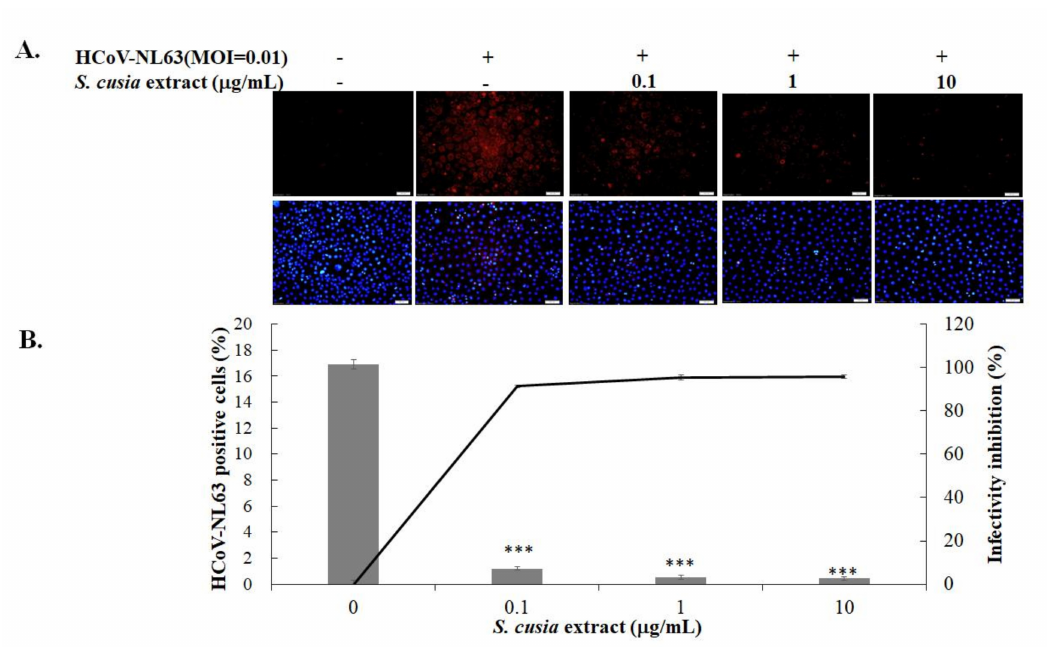
Figure 2. Inhibition of HCoV-NL63 infectivity by S. cusia leaf methanol extract. LLC-MK2 cells were infected with HCoV-NL63 and immediately treated with the extract for 36 h at 37 ◦ C, and then subjected to immunofluorescence staining with anti-HCoV-NL63 immunized sera and secondary antibody Alexa Fluor anti-mouse IgG ( A , top); total cells were stained with 4 (cid:48) ,6-diamidino-2-phenylindole (DAPI) ( A , bottom). Infectivity inhibition was determined according to the decrease in the ratio of HCoV-NL63-positive cells to total cells ( B ). + , add; − , not add; ***, p value < 0.001 compared with untreated infected cells. Scale bar, 100 µ